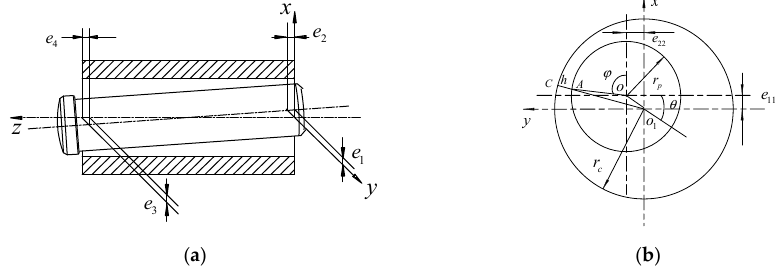
Figure 2. ( a ) Attitude diagram of piston in piston cavity; ( b ) variable schematic diagram at cross section of piston end